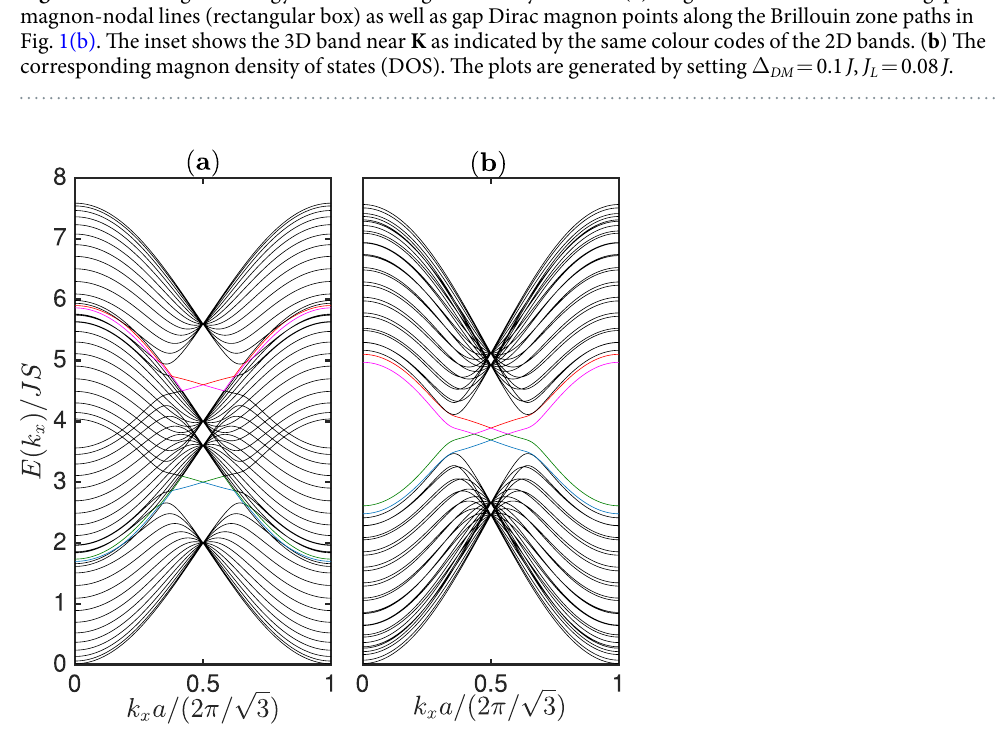
Figure 7. Magnon bulk bands (black lines) and chiral magnon edge modes (coloured lines). A strip of width N y = 14 unit cells with open boundary conditions along y and infinite along x is used. The plots are generated by setting